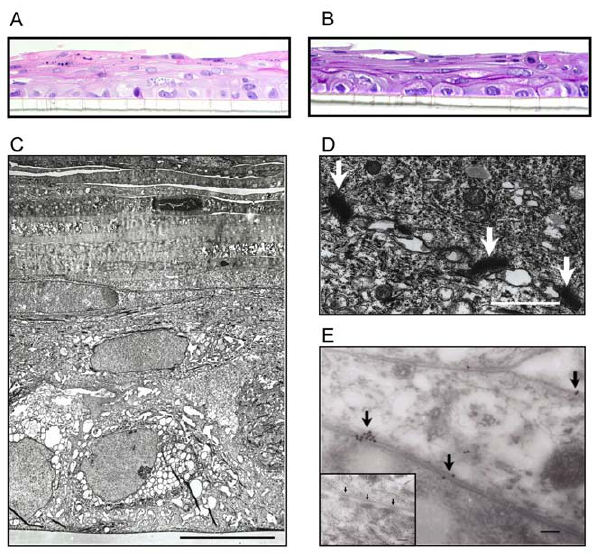
Figure 1. Human immortalized VEC differentiated into multi- layers with air-interfaces morphologically similar to vaginal stratified squamous epithelium. A . A representative H&E (400 6 ) staining of a d 9 V19I VEC multilayer 5 um section that illustrates the formation of multiple cell layers. The transwell porous membrane can be seen at the bottom of the micrograph. B . PAS staining of a 5 uM section through a VEC multilayer illustrated the substantial amounts of glycogen produced. VEC grown in standard format did not stain by PAS (data not shown). C . A representative transmission EM image of a d 9 V19I VEC multilayer culture ( . 7 layers) including the transwell porous support (bottom) and the apical anucleate layers sloughing from the top surface (bar=10 uM). The micrograph illustrates the intracellular structures and the formation of tight junctions indicating full polarization and differentiation. D . Tight junction complexes (white arrows) were observed between the plasma membranes of VEC within 7–9 d of plating (bar=100 nm) and were confirmed, E ., by immuno- gold labeling for occludin (black arrows show gold particle deposition; bar=100 nM). Inset panel: A secondary antibody control transmission EM showed no labeling at the tight junction complexes (black arrows, bar=100